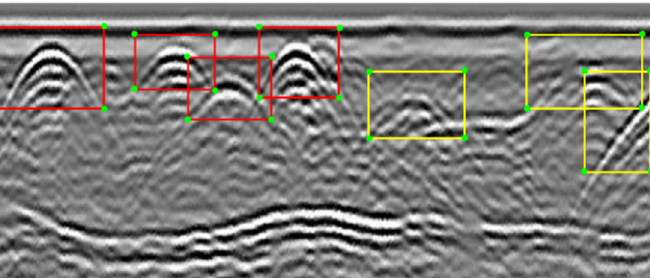
Figure 3. Schematic diagram of hyperbolic labeling. The red area indicates the framed hyperbola that needs to be labeled, while the yellow area indicates that the label was not generated because the hyperbola was blurred or there was only a small part of the hyperbola waveform.